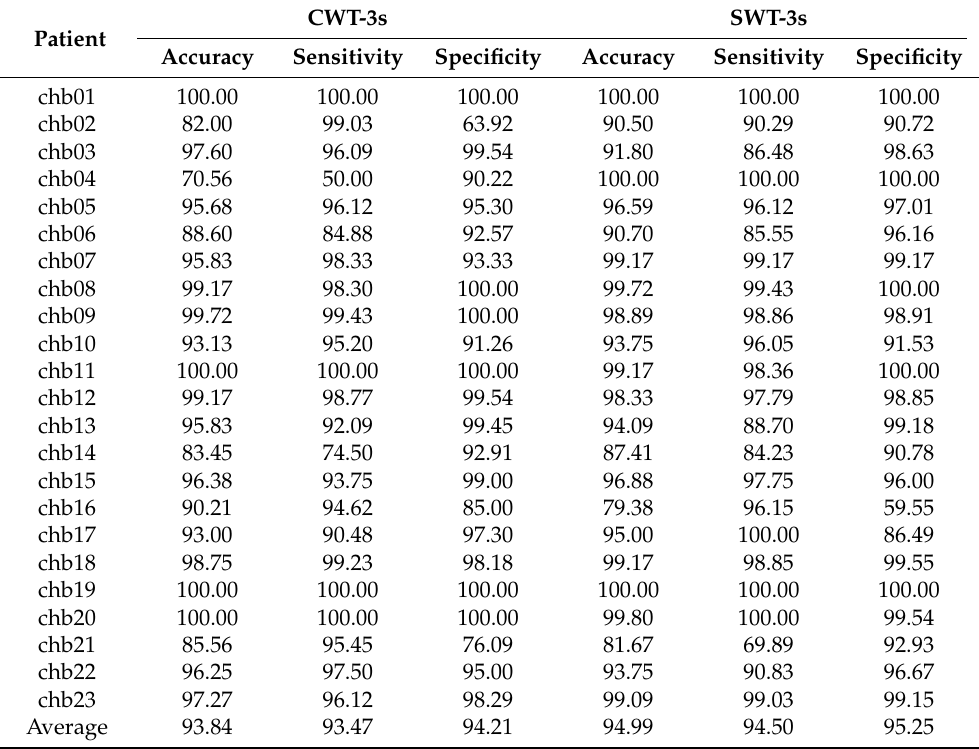
Table 4. The comparison of 3 s CWT and SWT segments under VGG16 model, using 5-fold cross